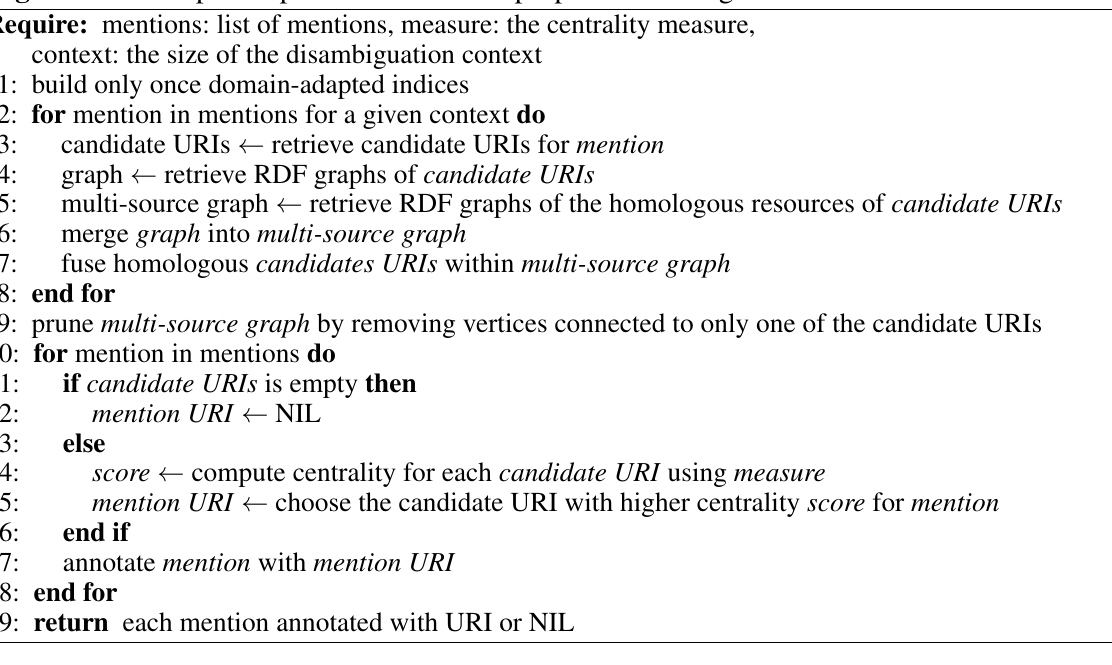
Algorithm 1 Simplified pseudo-code of the proposed NEL